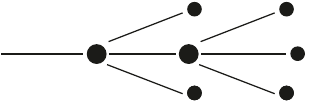
Figure 2: The molecular structure of 𝑅 2 : eythl.